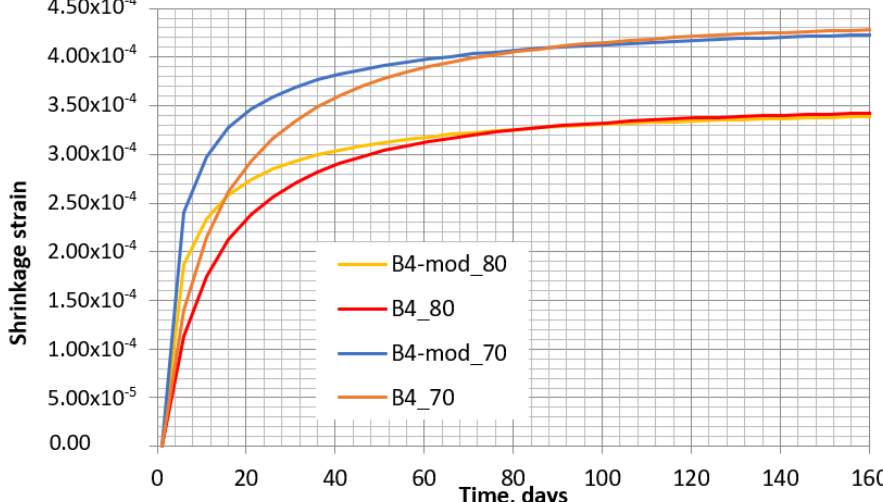
Figure 13. Shrinkage at humidity of 70% and 80% according to B4 model (B4_70 and B4_80, respectively) and modified B4-mod model (B4-mod_70 and B4-mod_80, respectively) in 160 days period.